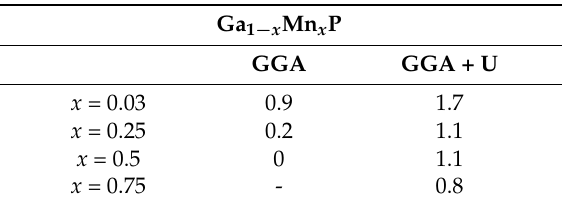
Table 1. The calculated half-metallic gap of Ga 1 − x Mn x P alloys ( x = 0.03, 0.25, 0.5, and 0.75) for spin-down channel by using GGA and GGA+U